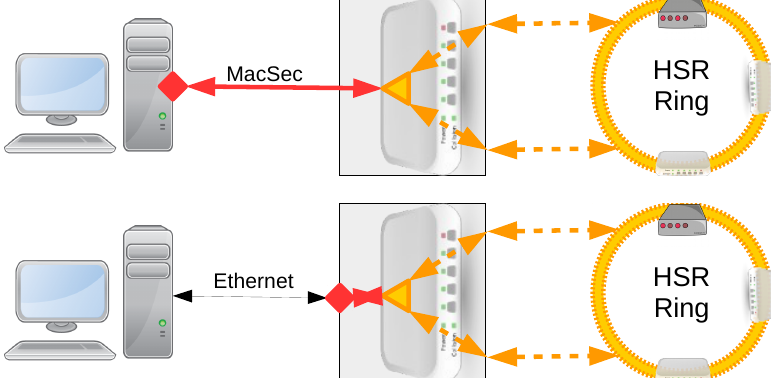
Figure 10. MACsec in HSR can be done at two different levels. (Top) MACsec added in the processing unit. (Bottom) tag added in the switch interlink port. Dashed lines indicate standard HSR traffic. Continuous lines indicate standard Ethernet. MACsec header is inserted before HSR processing; all the traffic in the ring is HSR compliant. If the MACsec tag is inserted inside the switch, some of the